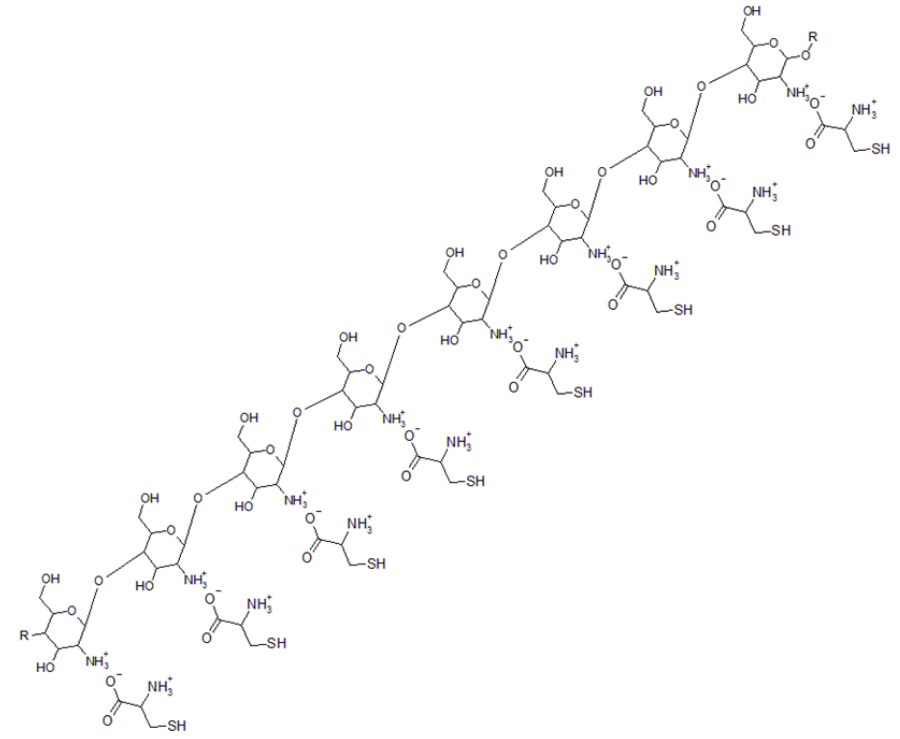
Figure 5. Chitosan cationized by NAC. The carboxylic group of NAC protonates the aminic group of Glucosamine, producing a polycation.